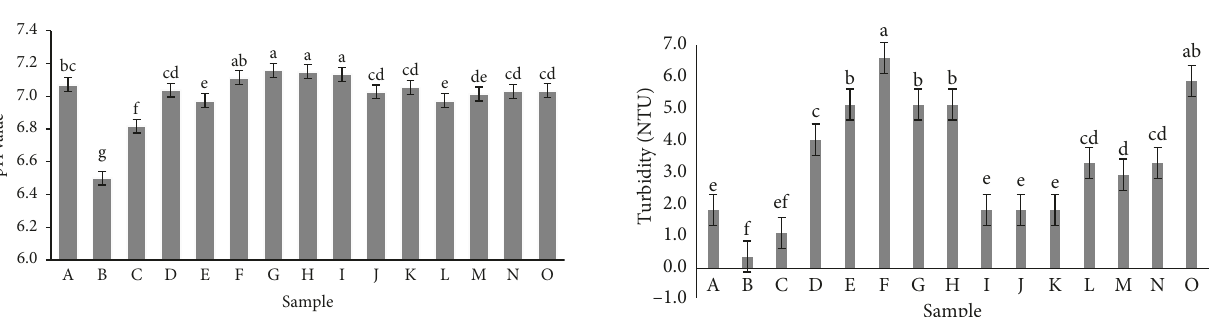
Figure 2: The turbidity for 15 samples of treated water. A-B: Sg. Ramal ; C-E: Section 8, Bandar Baru Bangi ; F-I: Section 16, Bandar Baru Bangi ; J, K, and O Section 3, Bandar Baru Bangi ; L-N: Section 15, Bandar Baru Bangi . All results are expressed in mean ± SD. a-f Values for the samples which have different letters are signifi- cantly different ( p < 0 . 05).